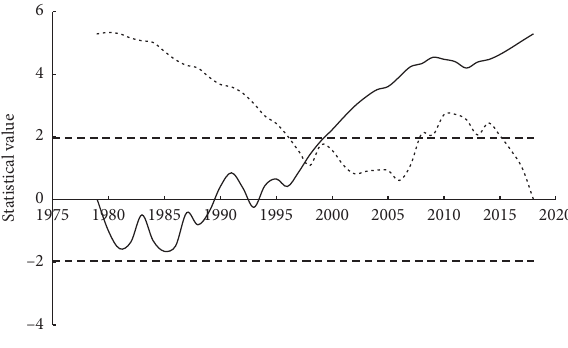
Figure 5: Years of abrupt change in annual ST1. Table 2: Abrupt change years of annual and seasonal soil temperatures over the Poyang Lake Basin.